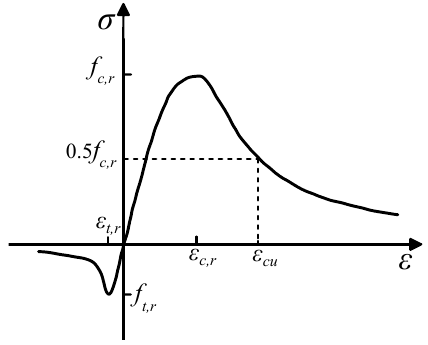
Figure 13. Stress–strain model used for confined concrete.